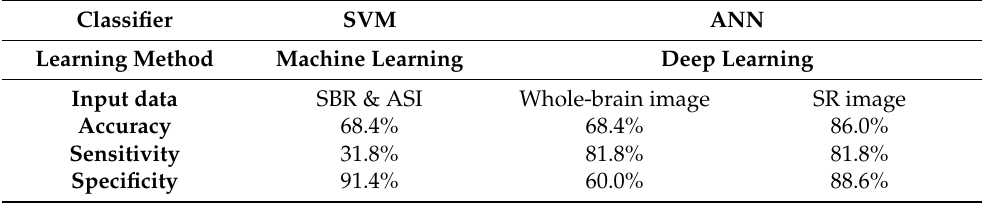
Table 3. Confusion matrix of ANN classifier for predicting PD.